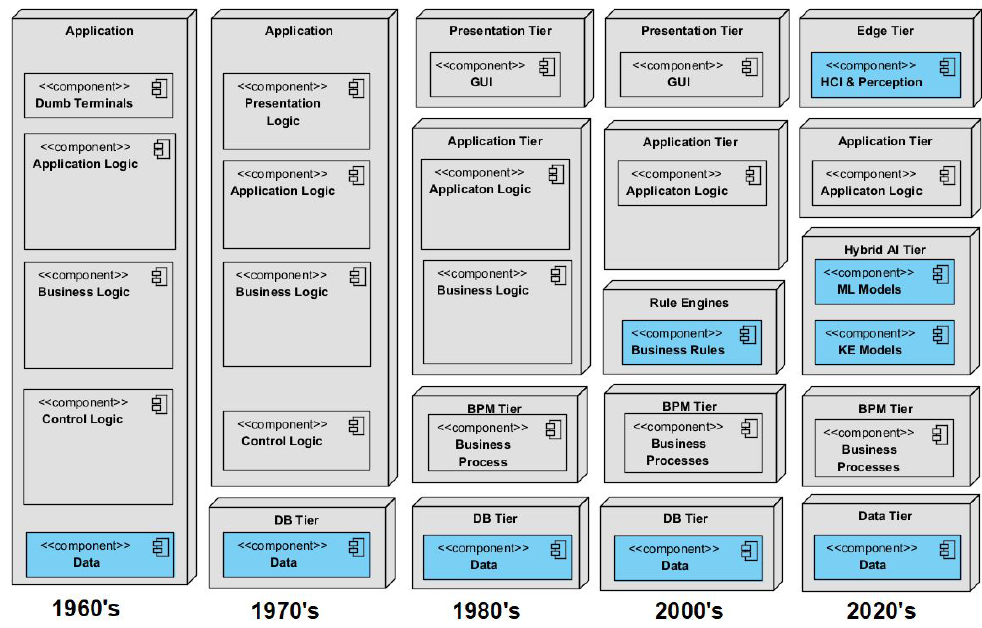
Figure 3. N-Tier Software Architecture incorporating AI based